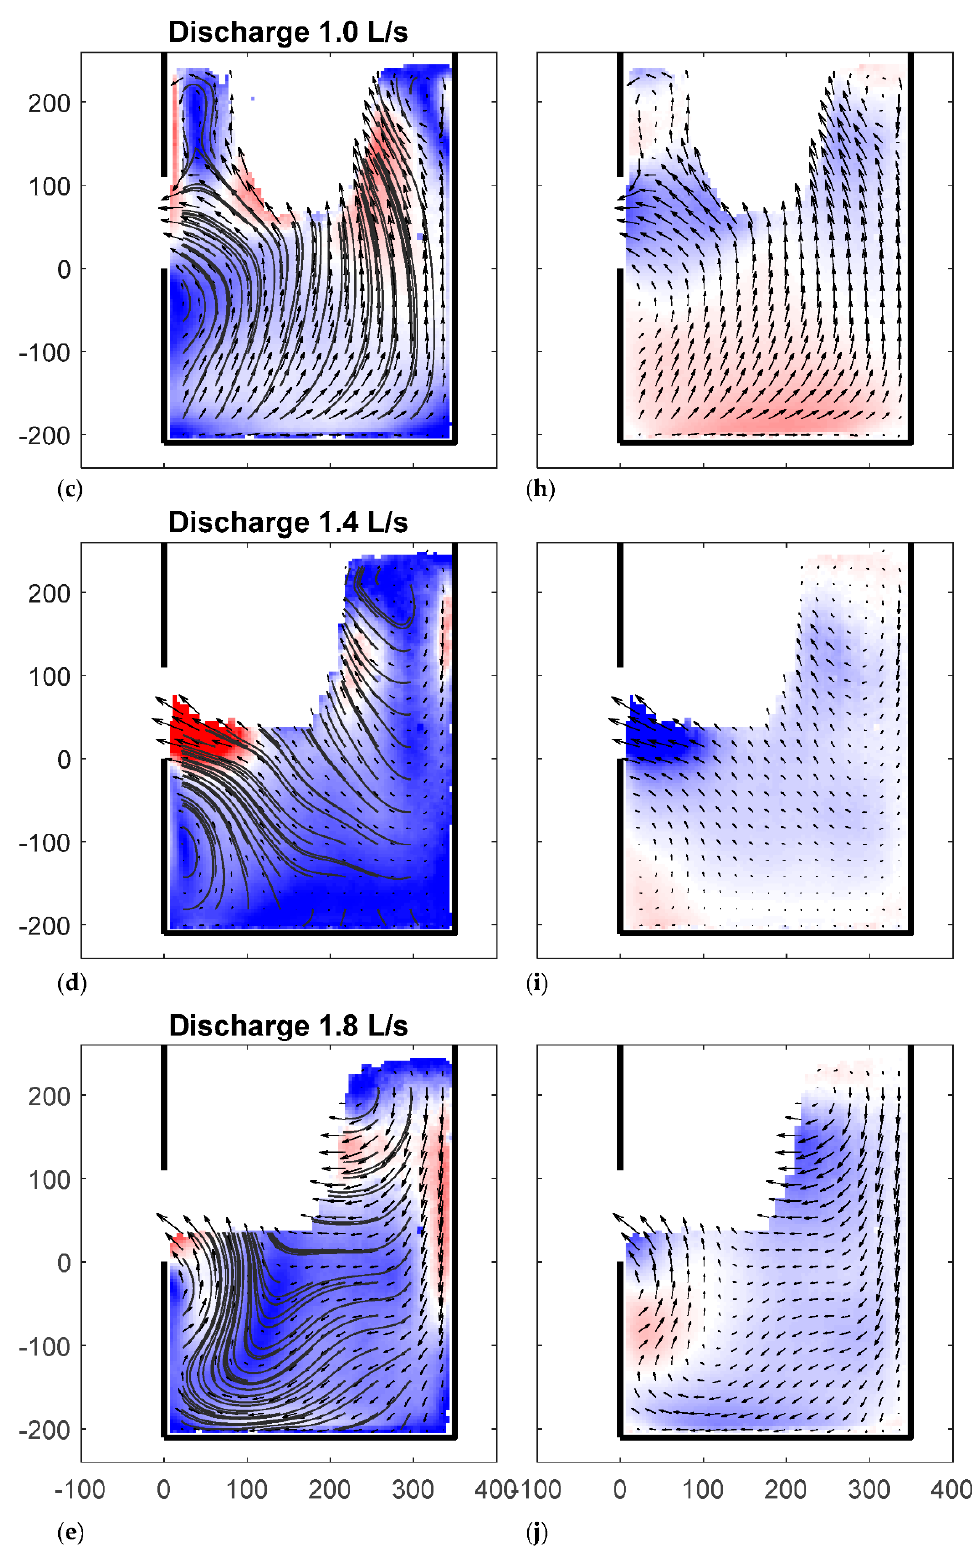
Figure 14. The effect of the discharge on the flow field. ( a – e ) Mean velocity; ( f – j ) x-velocity. The monitored plane in Figure 14 is the vertical plane of symmetry of the gully pot. Figure 15 shows the horizontal flow field close to the gully pot bottom (plane 4 in Figure 5). The flow field at a discharge of 0.55 and 1.0 L/s is relatively symmetrical over a vertical line in the middle, while for a